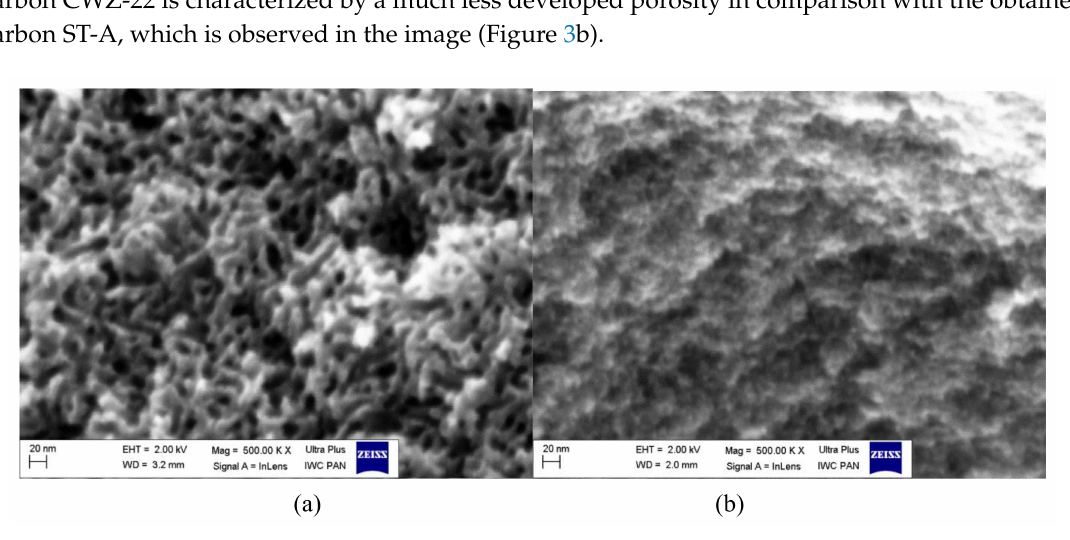
Figure 3. SEM images of carbons: ST-A ( a ), CWZ-22 ( b ).